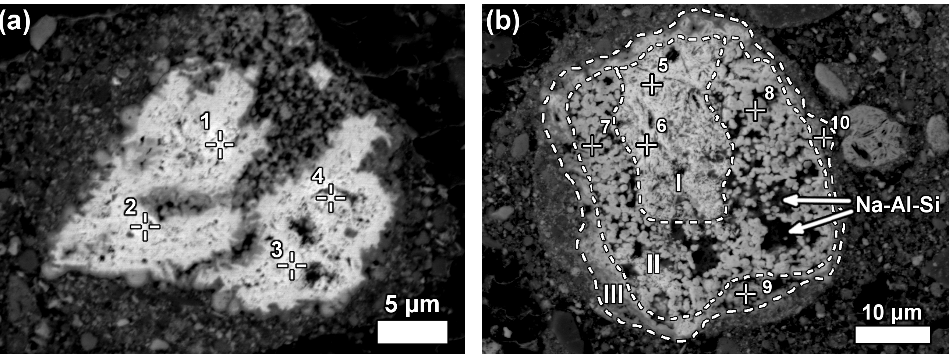
Figure 8. Neodymium-lanthanum predominant LREE particles, of which ( a ) is partly reacted, and ( b ). exhibits a zonation (I–III) relating to reaction stages with Bayer liquor. Within zone II of ( b ), deposition of a sodium aluminosilicate phase (Na-Al-Si) is indicated. Table 6 . EPMA-WDS quantification (wt %) of a neodymium-lanthanum predominant partly reacted